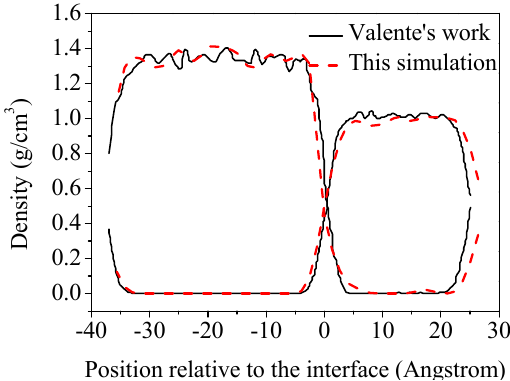
Figure 2. Comparison of concentration profiles of water and octane molecules at the oil – water interface between the present simulation and Valente’s work.